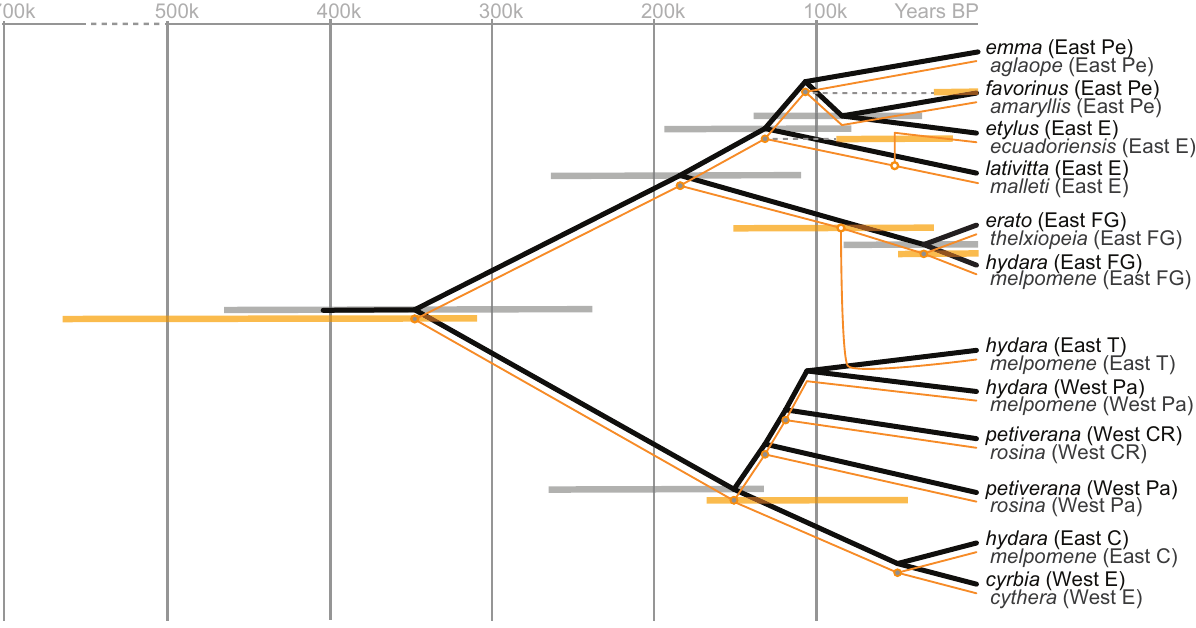
Figure 3. Cophylogenetic reconstruction of the history of mimicry between country level populations of H.erato and H.melpomene . Example cophylogenetic history of the mimicry relationship between H. erato and H. melpomene based on MDC phylogenetic estimates (shown in Figure 2), and reconstructed using TreeMap 3. Bars indicate 95% Bayesian confidence intervals for divergence times, corresponding to Figure S1. Grey-filled dots correspond to reconstructed codivergence events; white-filled dots represent duplication events which, in this case, are both followed by model switch events – one for the colonisation of H. erato etylus in East Ecuador by H. melpomene ecuadoriensis , here the sister to H. melpomene malleti (also from East Ecuador), the other for the colonisation of the H. erato hydara population from Trinidad by a population of H. melpomene melpomene , here the sister of a lineage from French Guiana (one of the sampled mainland countries closest to Trinidad); the only mimicry loss event is indicated at the most recent common ancestor of H. erato hydara populations from Trinidad and Panama. Taxon labels correspond to those in Figure 2.